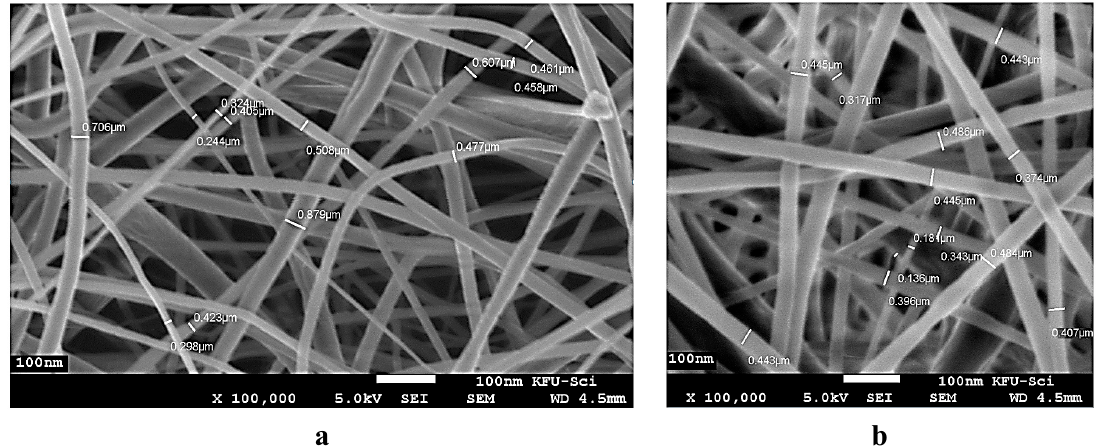
Figure 1. Scanning electron microscopy of PCL/MAA (14% w / v ) graft copolymer nanofibers ( a ); and PCL/MAA graft copolymer nanofibers containing silver nitrate 5% ( b ).